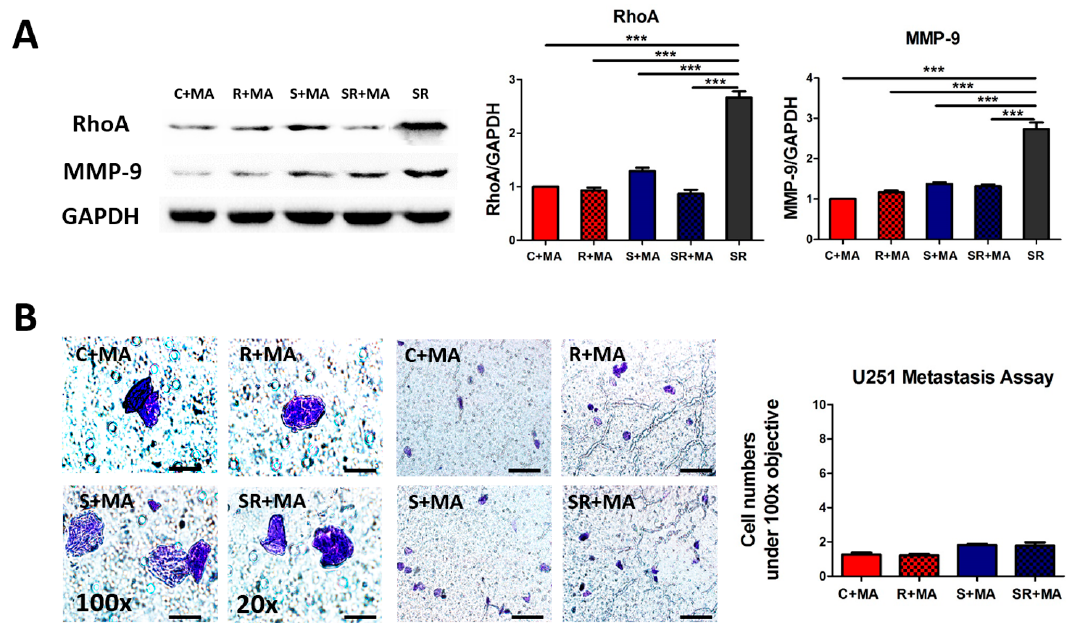
Figure 7. Metastasis factors protein expression and metastasis ability following MA treatment. ( A ) No changes were observed in RhoA and MMP-9 protein expression by western blot. GADPH served as the loading control. The data represent the means ± S.D. of three independent experiments. *** p < 0.0001 versus different treated groups; ( B ) Metastasis assay is followed the MA treatment, U251 cells were stained by Giemsa dye and the blue-violet cells are observed under 20× (Scale bar equals 100 μ m) and 100× (Scale bar equals 20 μ m), and five random fields were selected to count the metastatic cells. C, Control; R, Radiation; S, starvation; SR, starvation + radiation; MA, mithramycin.